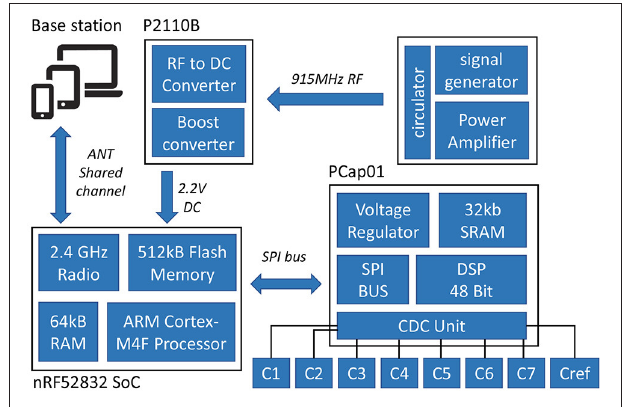
FIGURE 1 | Block diagram of the multi-point wireless sensor